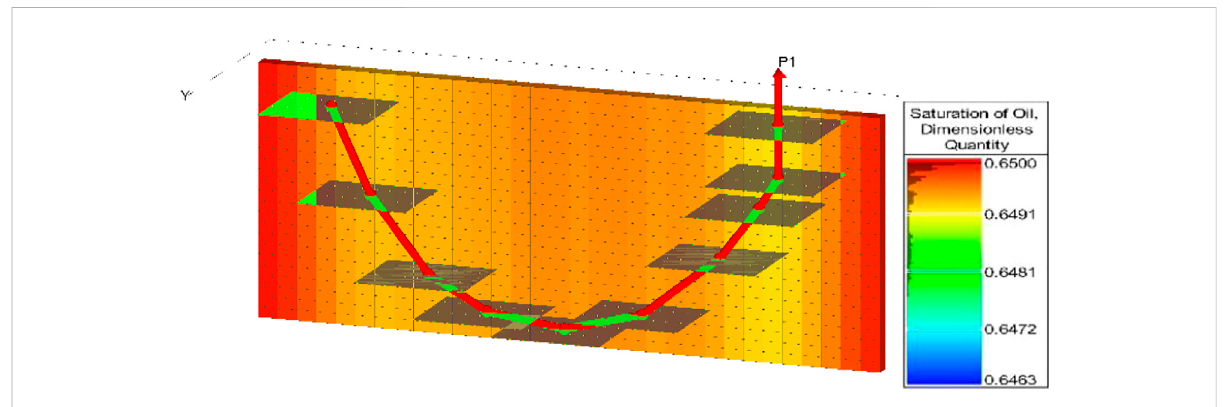
FIGURE 3 Simulation of bow horizontal well with horizontal